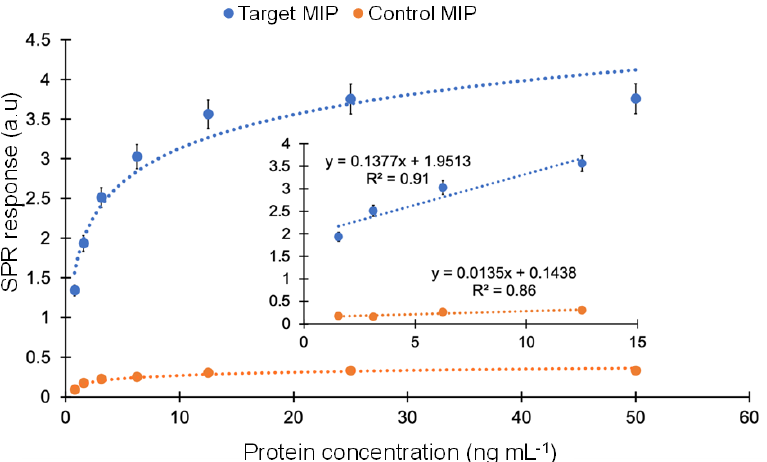
Figure 9. Comparison of affinity binding between the target and control MIPs in the concentration range of 0.78 – 50 ng mL −1 .